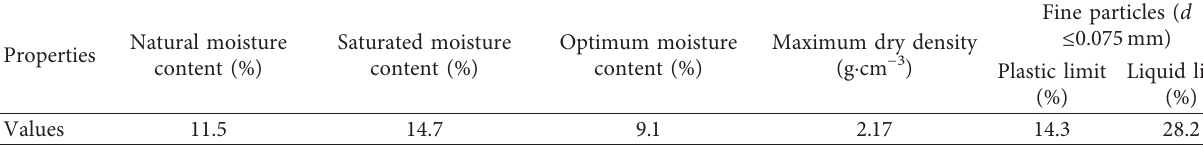
Table 1: Physical parameters of tested soil.